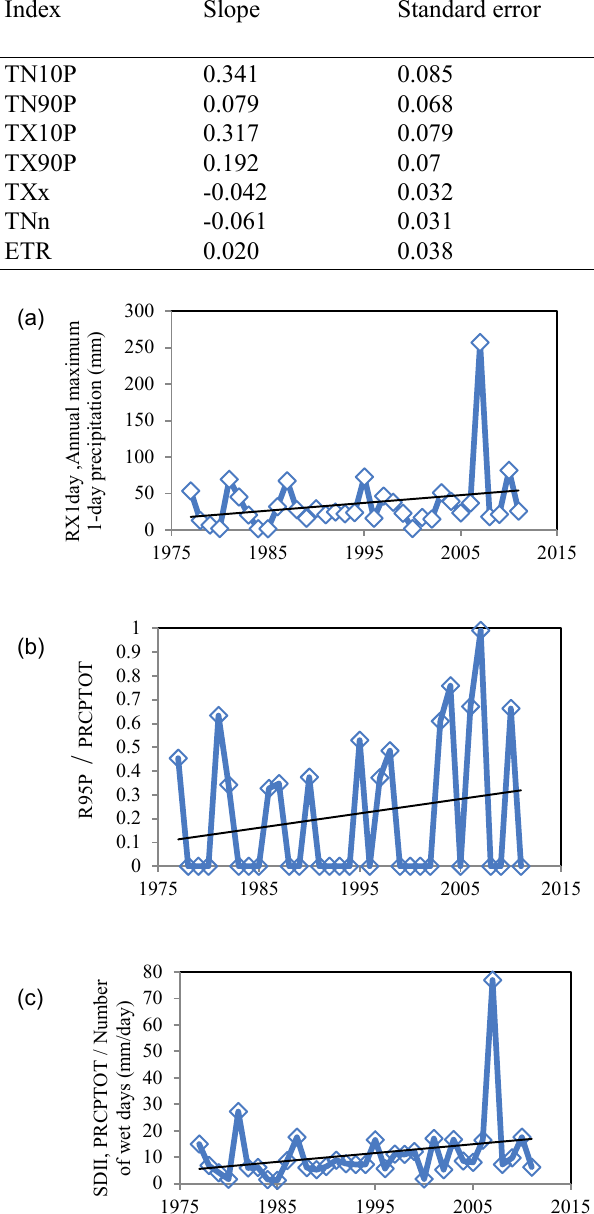
Table 1 Test statistics of temperature indices.